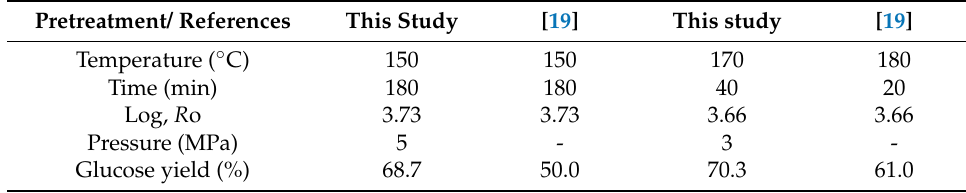
Table 4. Comparative analyses between subcritical H 2 O and subcritical H 2 O-CO 2 pretreatments of OPMF on sugar